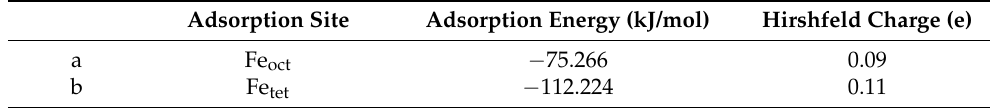
Figure 9. Stable adsorption configurations of H 2 O onto Fe tet site ( a ), Fe oct site ( b ) of the γ -Fe 2 O 3 (111) surface (Fe, purple; H, white; O, red). Table 4. The parameters of optimized configurations of the γ -Fe 2 O 3 (111) surface-adsorbed H 2 O molecule.